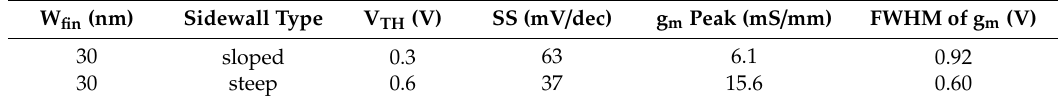
Table 2. Key parameters for each device exhibited in Figure 3.